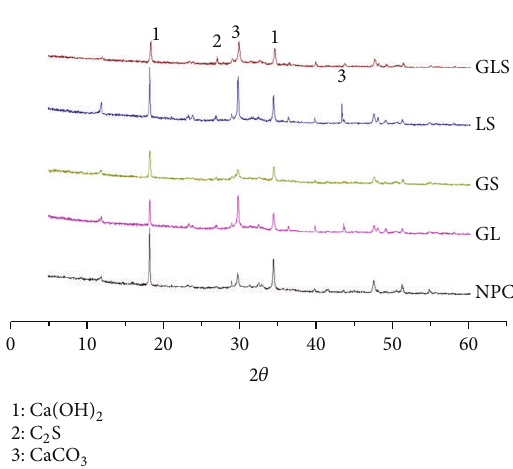
Figure 3: XRD results of samples at 90